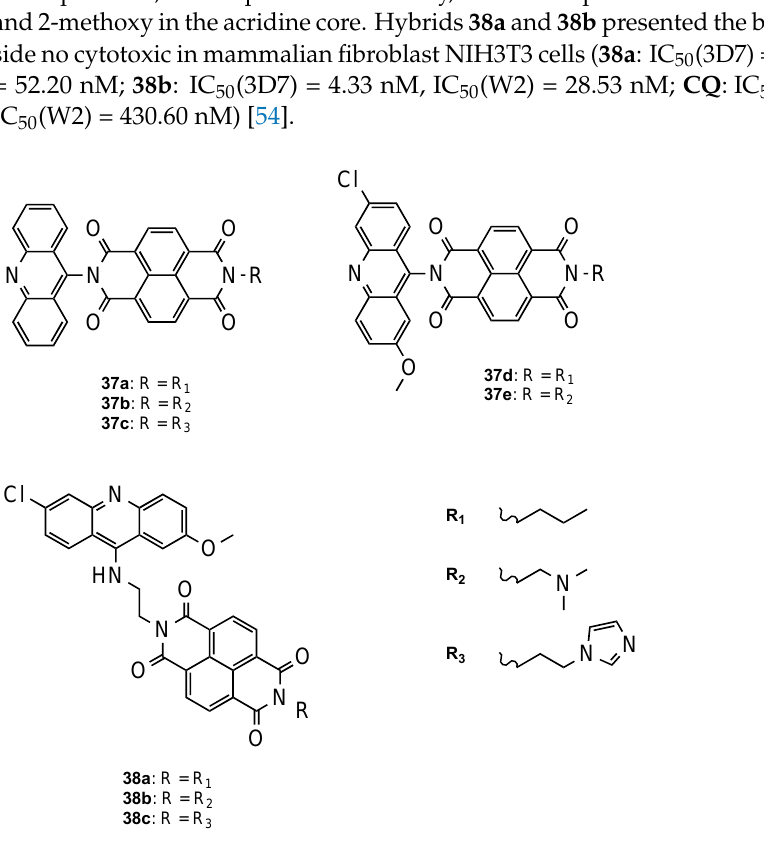
Figure 23. Steroidal ( 34 and 35 ) and adamantane ( 36 ) aminoacridine derivatives synthesized by Tot and co-workers [53].